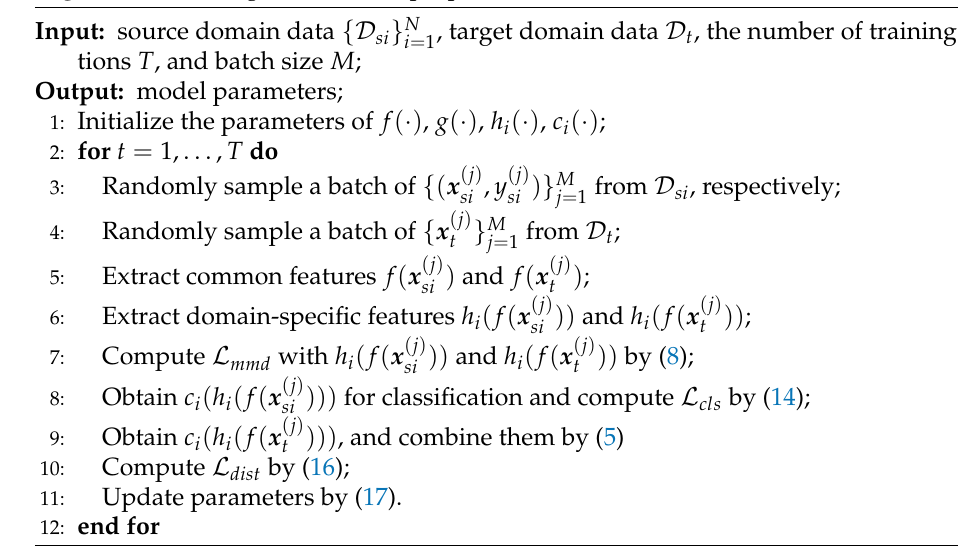
Algorithm 1 The algorithm of the proposed